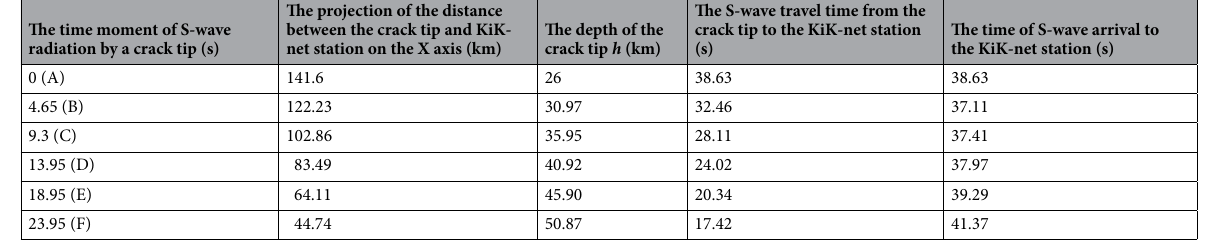
Table 3. Duration of strong motion that was observed at station KSRH06 as a result of crack propagation over a certain part of the fault plane during the Tokachi-oki event ( l ~ 100 km, α ~ 14.4°, V ~ 4.3–4.0 km/s). The duration of strong motion: 4.25 s.